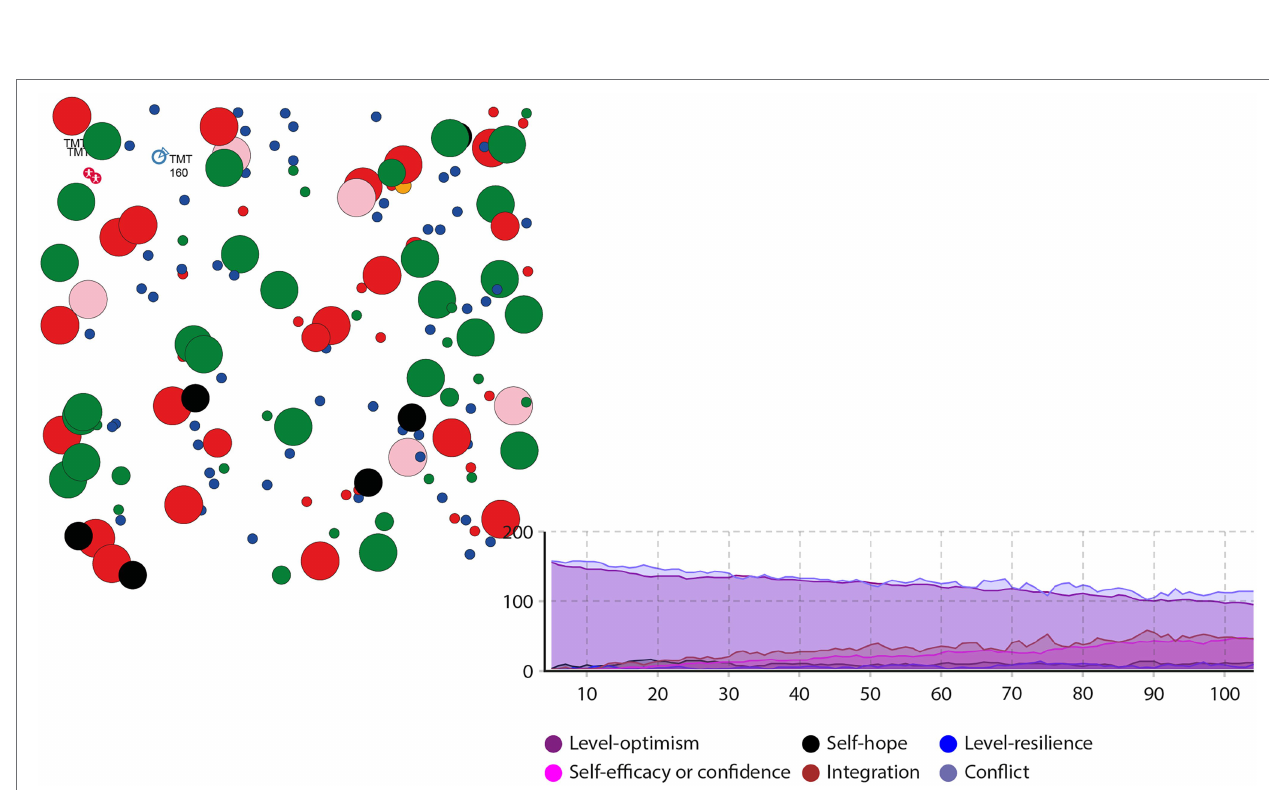
FIGURE 3 | Status chart of the conflict and integration of behaviors affected by COVID-19 Chinese mixed-ownership reform